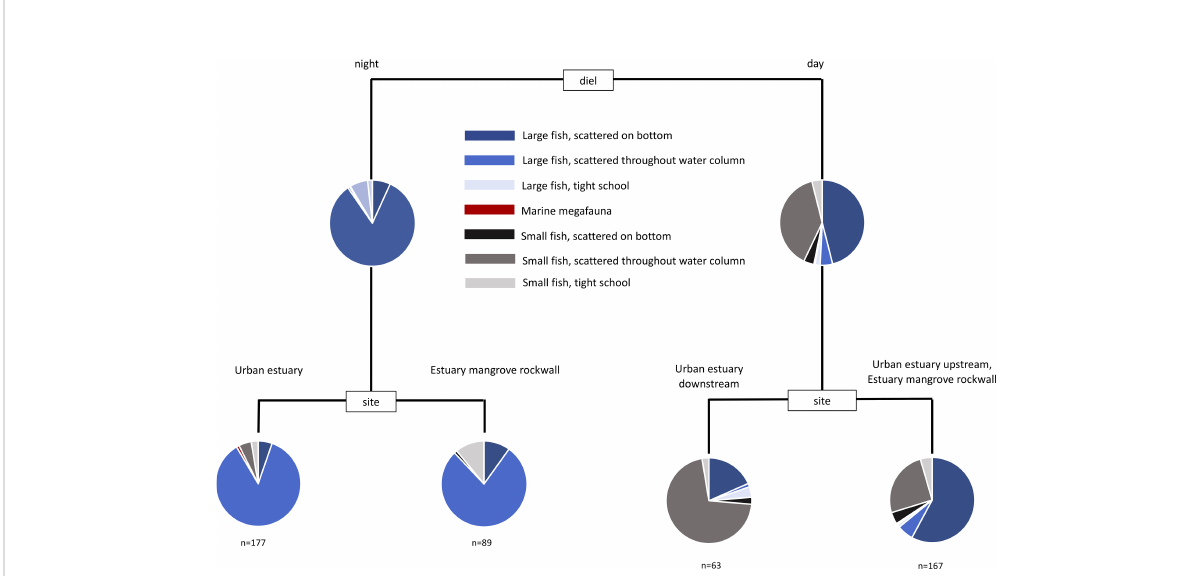
FIGURE 5 Multivariate classi fi cation and regression tree of the assemblage of mobile marine fauna from sonar sampling conducted in the Pioneer River estuary. Sites were replicated at every sampling event and across day and night (see Table